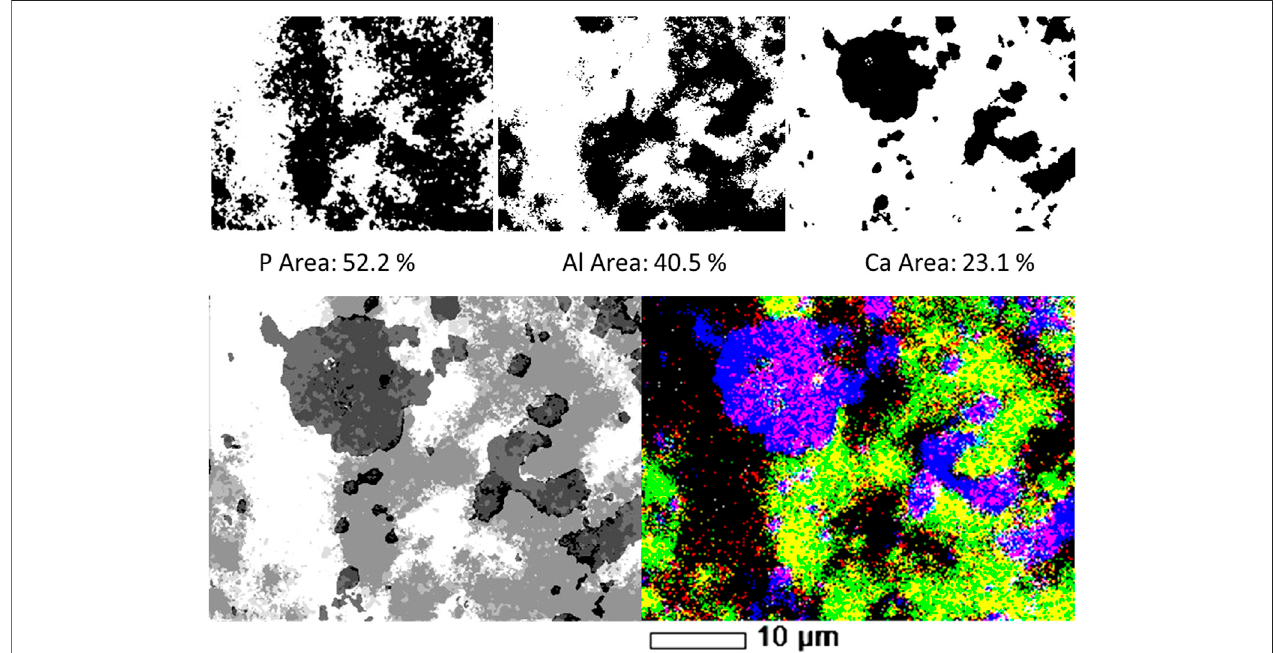
FIGURE 4 | Top row: P, Al and Ca individual fi ltered, binary images, and the areas occupied by each element on SL-Al/O-WTR surface. Bottom row: Combination of three elemental (P, Al and Ca) images of SL-Al/O-WTR. Segmented image, processed by the image analysis working procedure (left) compared to the SEM-EDS overlay map displayed in 100% contrast (right)